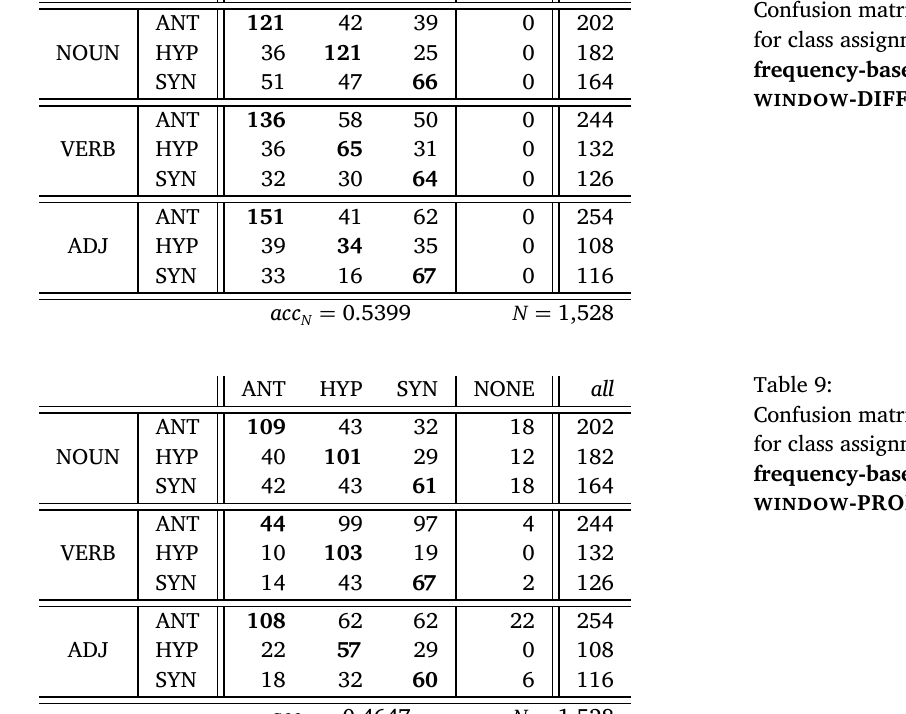
Confusion matrix for class assignment using